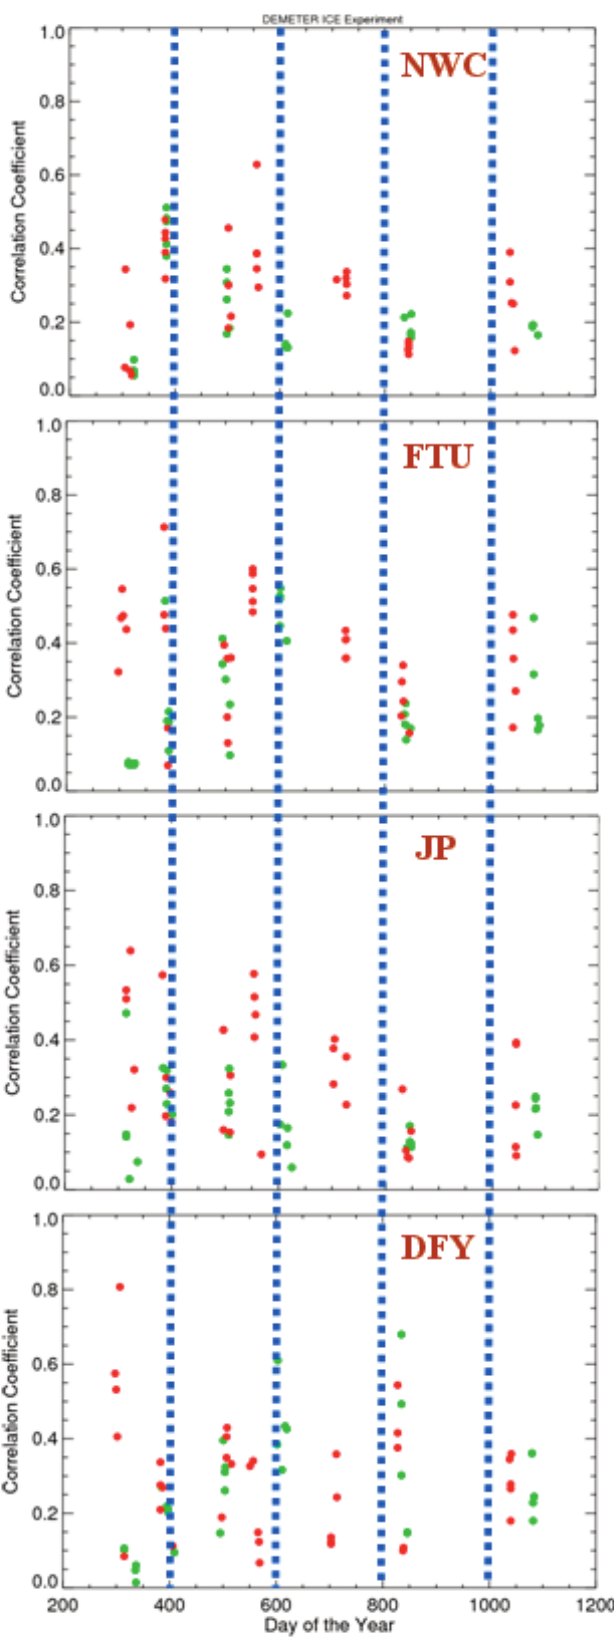
Figure 4. Variations in the degree of correlations versus the DOY. The red/green circles correspond to the degrees of correlations between the sunspot/Ap-index and the VLF transmitter signals, for the Australia (NWC, top panel), France (FTU, second panel), Japan (JP, third panel) and Germany (DFY, bottom